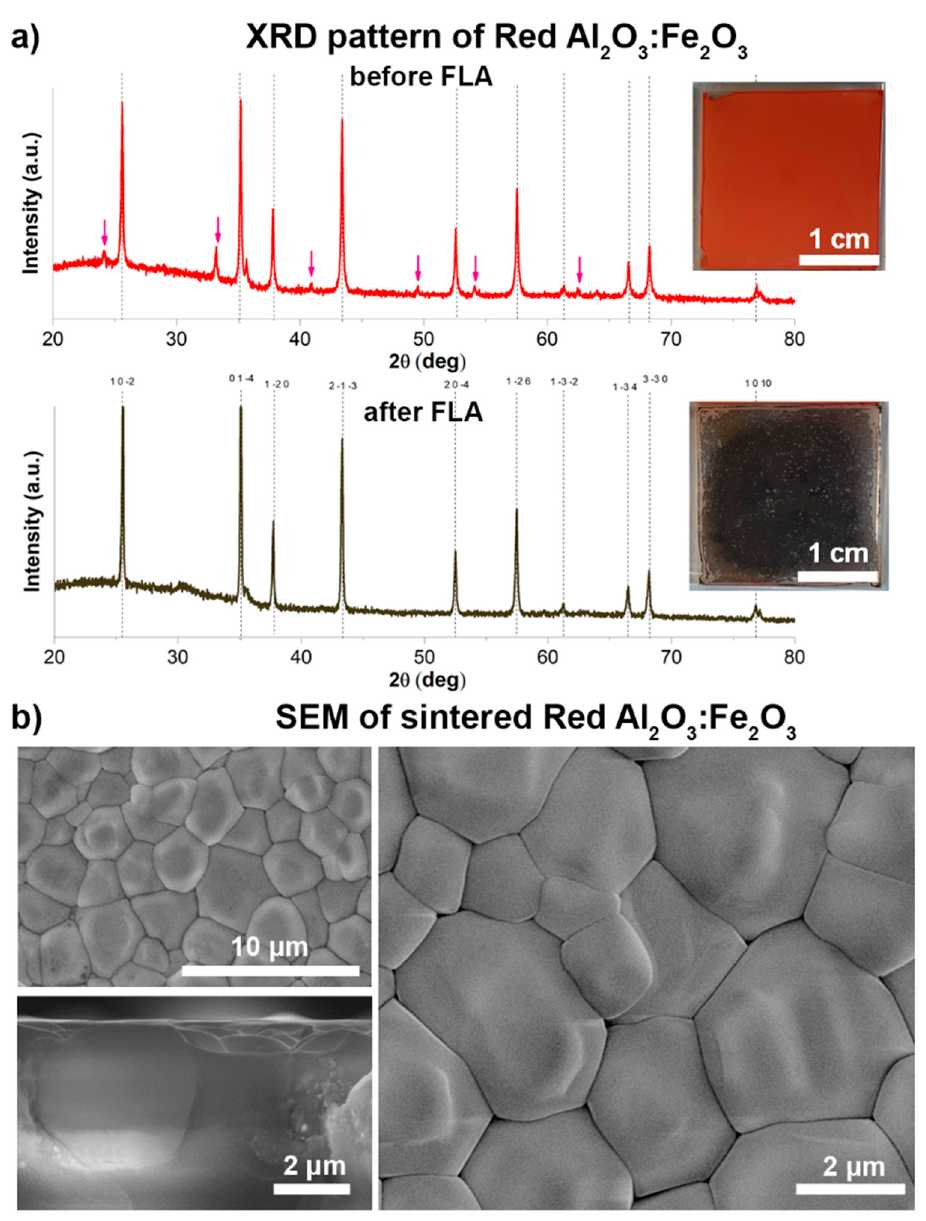
Figure 4. Characterization of the red Al 2 O 3 : Fe 2 O 3 ceramic film before and after FLA: ( a ) indexed XRD patterns of the ceramic films with representative sample photographs (red arrows showing the α -Fe 2 O 3 pattern); ( b ) top-view SEM images of FLA-sintered red Al 2 O 3 : Fe 2 O 3 ceramic films with different magnifications, as well as cross-sectional SEM image of the sintered film.